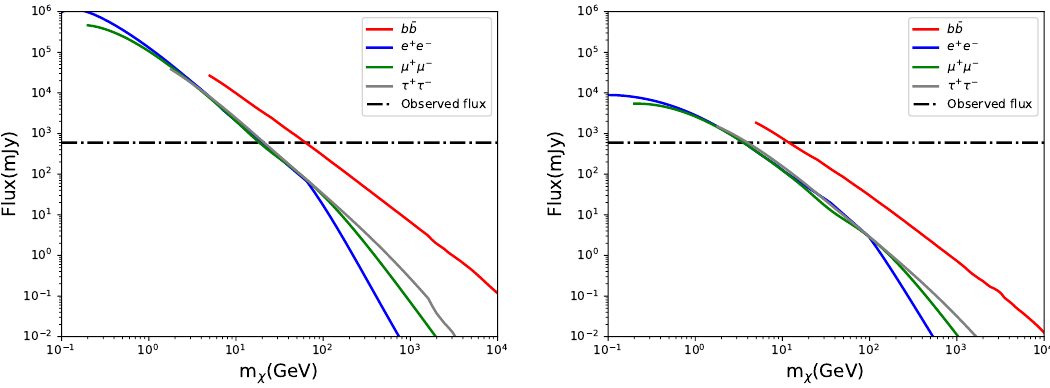
Figure 3 . The predicted flux of different cross section for four channels. The left/right panels are fluxes predicted by magnetic field at 1 G/30 G, respectively. And the cross-section used in left panel and right panel are h σv i = 10 − 32 cm 3 s − 1 and h σv i = 10 − 30 cm 3 s − 1 . The red line is b ¯ b , red line is e + e − , green line is µ + µ − , gray line is τ + τ − , and black dot-dashed line is the observed flux.